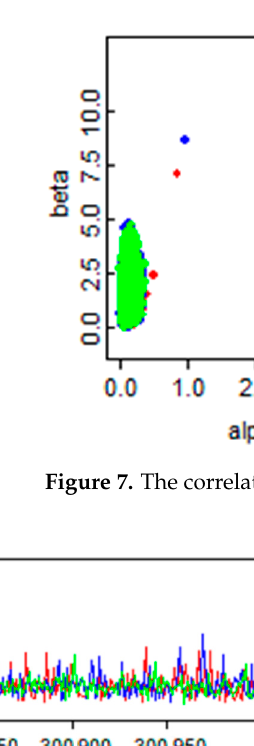
Figure 6. The trace of λ in the Markov chain Monte Carlo (MCMC) sampling.